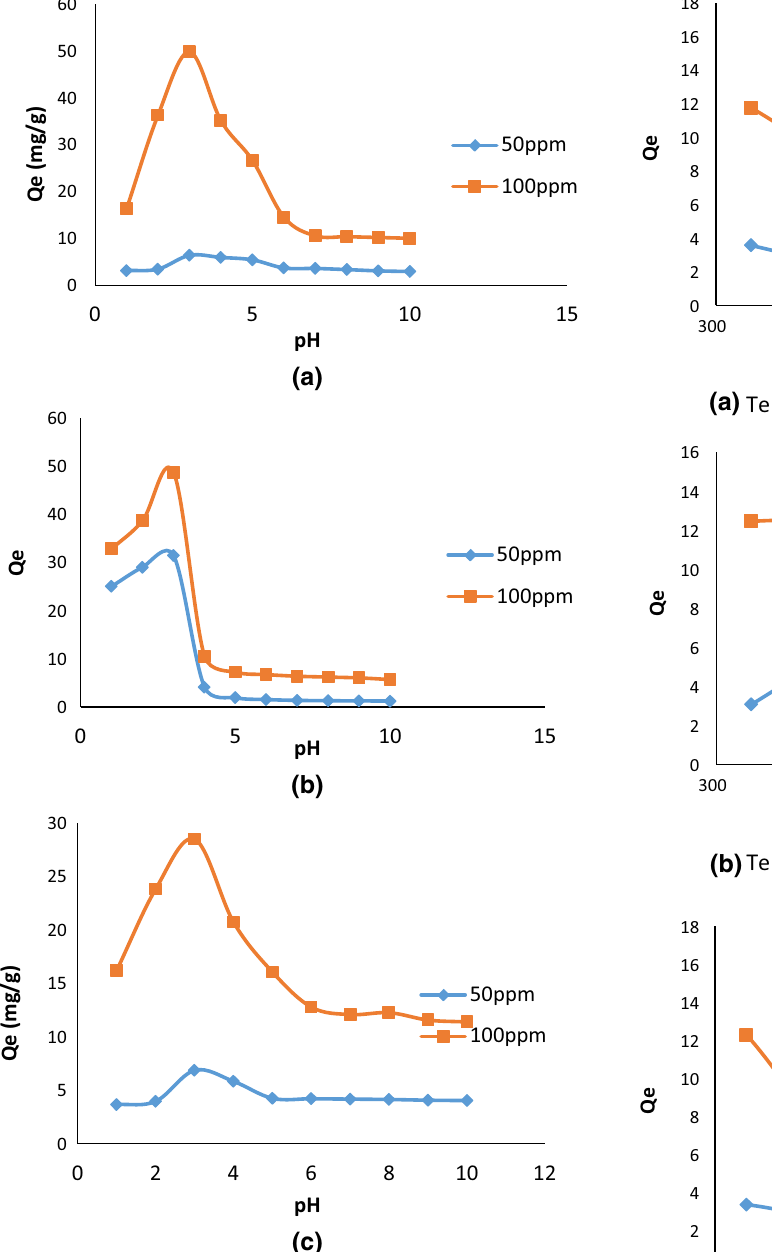
Temperature profile diagram for Cr(VI)//G